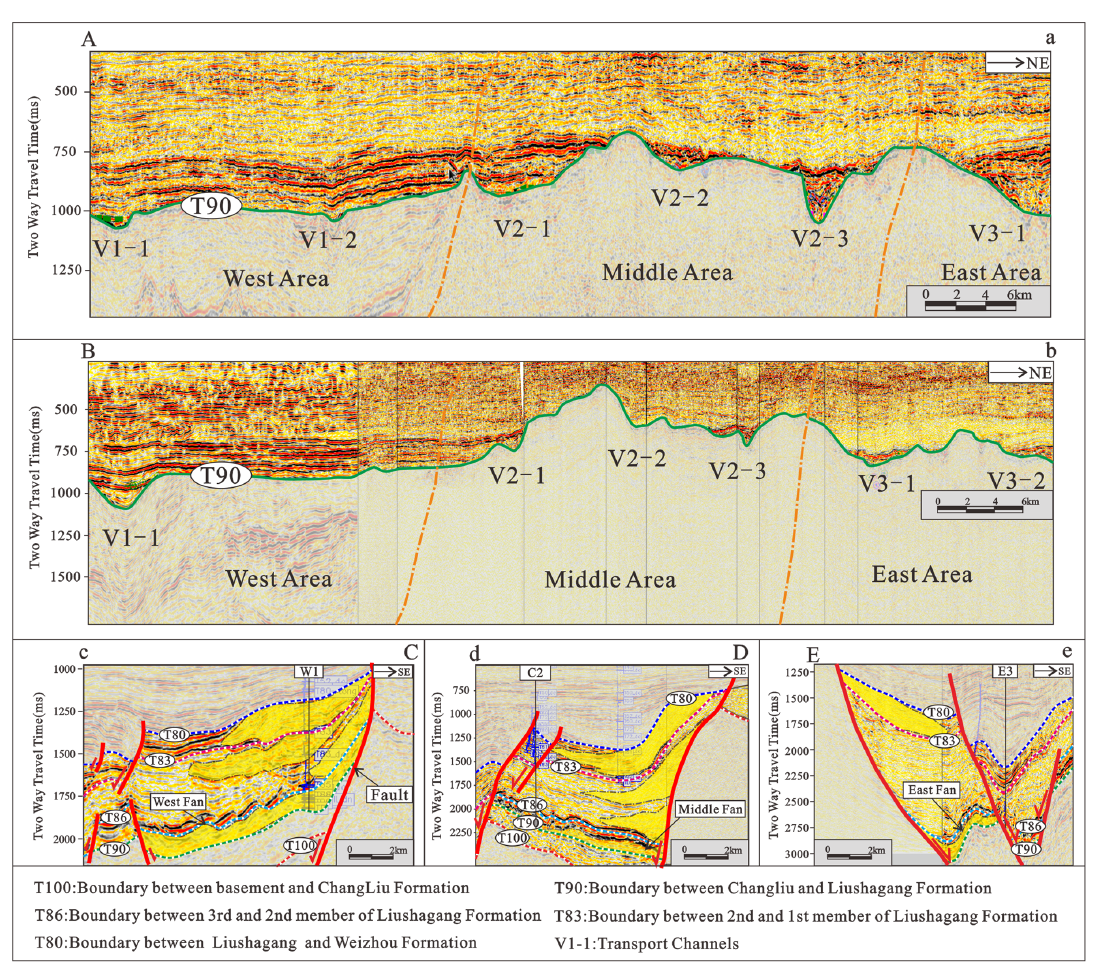
Figure 4. Interpreted seismic section Aa and Bb (SW–NE) of the gully and interpreted seismic section Cc, Dd, and Ee (NW–SE) of the sedimentary system in the northern steep-slope zone of the Weixinan Sag, Beibuwan Basin (the location of the section is shown in Figure